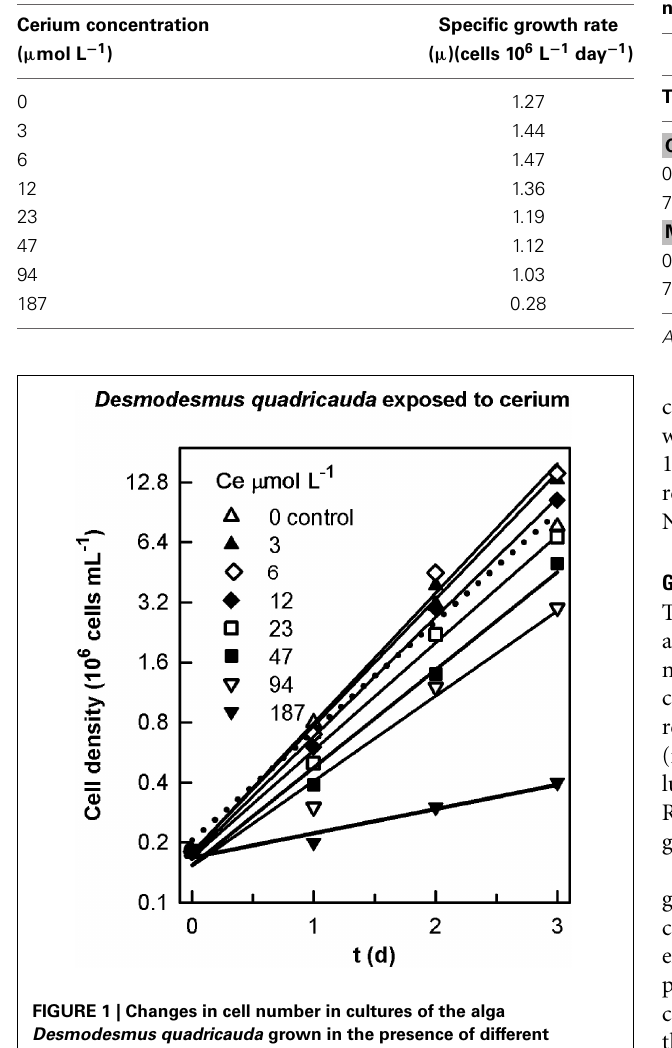
on algae and have demonstrated stimulatory and toxic effects on growth at lower ( < 25 μ mol L − 1 ) and higher concentrations ( > 25 μ mol L − 1 ), respectively ( Figure 1 ).